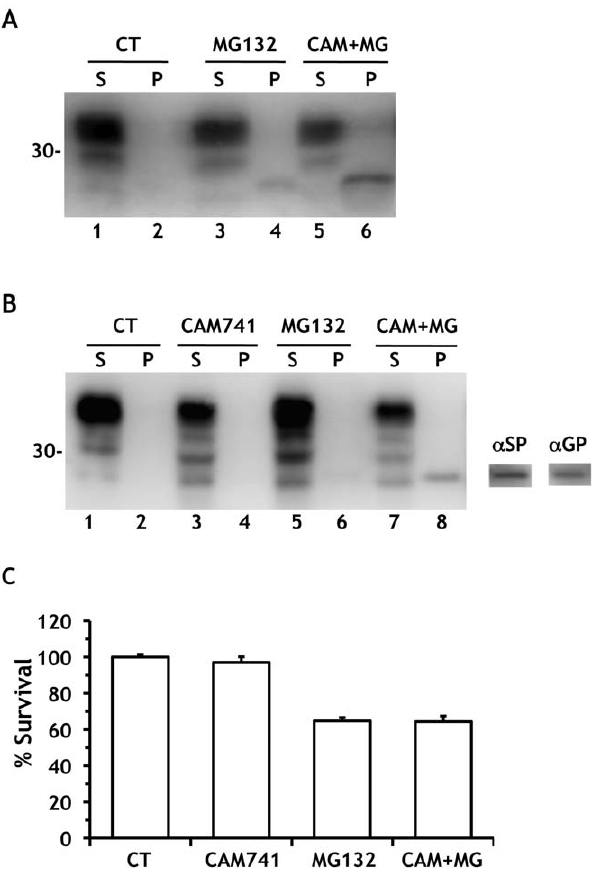
Figure 6. SP-PrP has no effect on viability of cerebellar granule neurons. (A) Hippocampal neurons from C57BL/6J mice were treated with 5 m M MG132 alone or with 10 m M CAM741 for 18 h, and PrP was analyzed by Western blot as described in the legend to Fig. 1. Note the higher level of SP-PrP in the presence of CAM741 (compare lanes 4 and 6). (B) Cerebellar granule neurons from C57BL/6J mice were treated with 10 m M CAM741, 10 m M MG132 or with the two drugs simulta- neously for 24 h, before Western blot analysis with antibody 12B2. The PrP band in lane 8 also reacted with the a -SP and a -GP antibodies (on the right). (C) Cell survival was quantified by MTT assay and expressed as a percentage of the values for cells treated with the vehicle. Data are the mean 6 SEM of 18–20 replicates from two independent experiments. The Bonferroni test did not find any difference between MG132 and CAM + MG